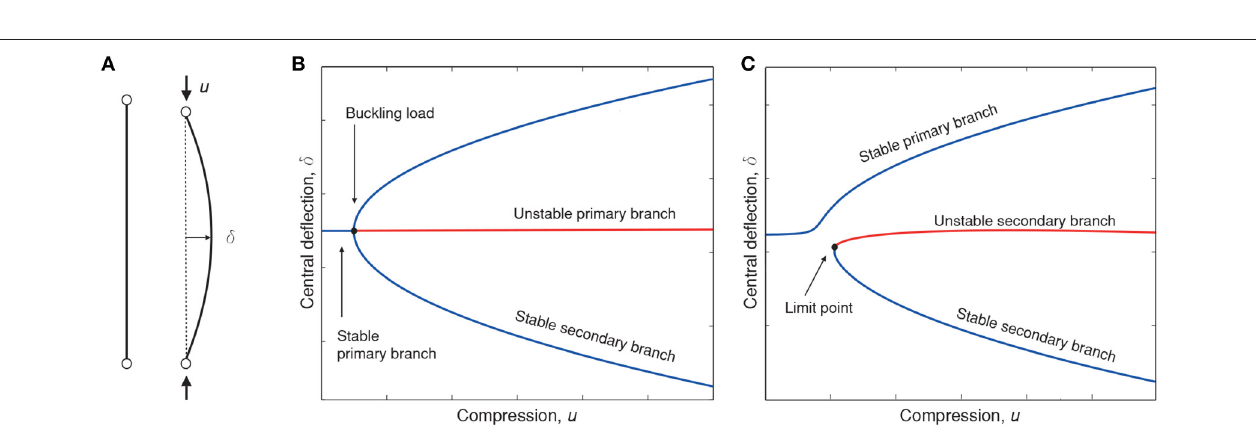
FIGURE 17 | Sandwich panel with prestressed lattice core, the unit cells of which can be represented as prestressed stayed columns, as highlighted in the lower diagram [90, 91].